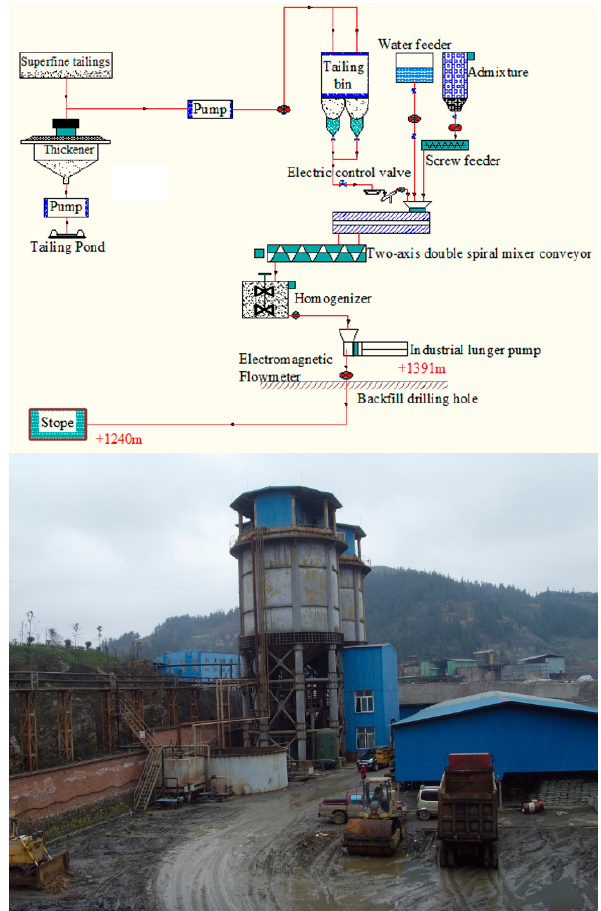
Figure 1. Backfilling technological process and industrial site.